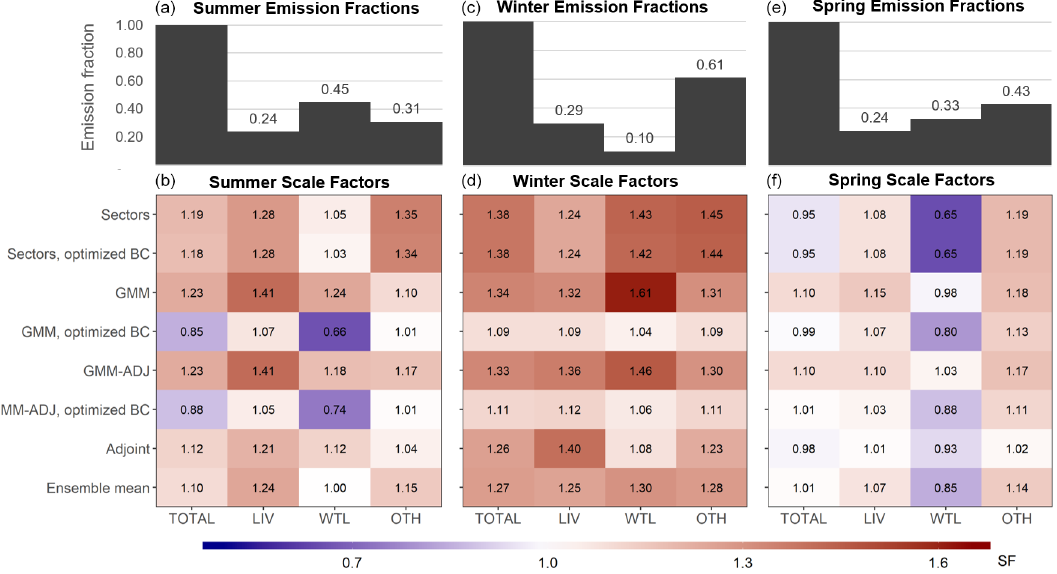
Figure 3. Methane emission scale factors by sector derived from the multi-inversion analysis over the Upper Midwest (black box in Fig. 1). Results are shown for GEM1 ( a, b ; July–August 2017), GEM2 ( c, d ; January 2018) and GEM3 ( e, f ; May–June 2018). Matrix columns show aggregated regional scale factors for total methane emissions (TOTAL), livestock (LIV), wetlands (WTL), and other sources (OTH). Rows show results from seven individual inversions (for details, see Sect. 2.3) along with the ensemble mean. Bar plots in the top row show the emission fractions for each source grouping based on the ensemble-mean inversion results. Boundary condition scale factors for the corresponding sector-based and GMM inversions are 1 . 00 / 1 . 02 (summer), 1 . 00 / 1 . 01 (winter) and 1 . 00 / 1 . 00 (spring), respectively.